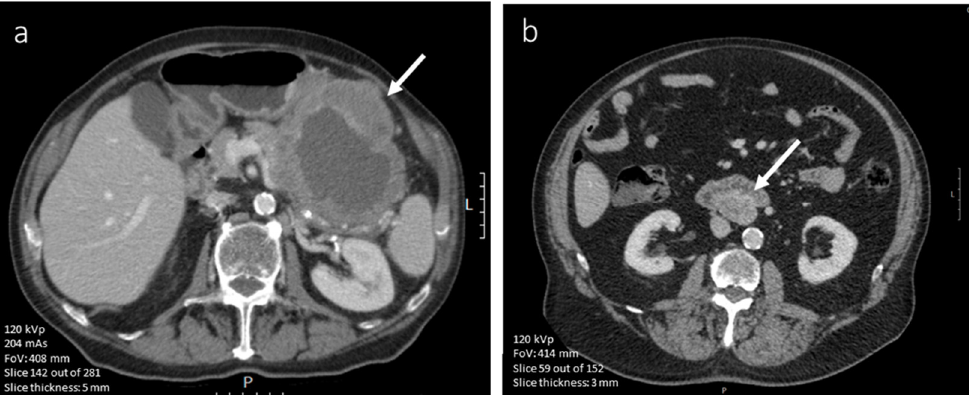
Figure 5. ( a , b ). Axial portal venous phase (iodinated contrast media) CT image of an 83-year-old male diagnosed with a high-risk (Miettinen AFIP classification) gastric GIST (scale bar 5 cm). The large lesion is lobulated and has central necrosis (arrow). ( b ) Axial portal venous phase (iodinated contrast media) CT slice of a 72-year-old male diagnosed with a low-risk GIST affecting the small intestine (scale bar 5 cm). It shows a well-defined and rounded lesion with a homogeneous enhancement pattern